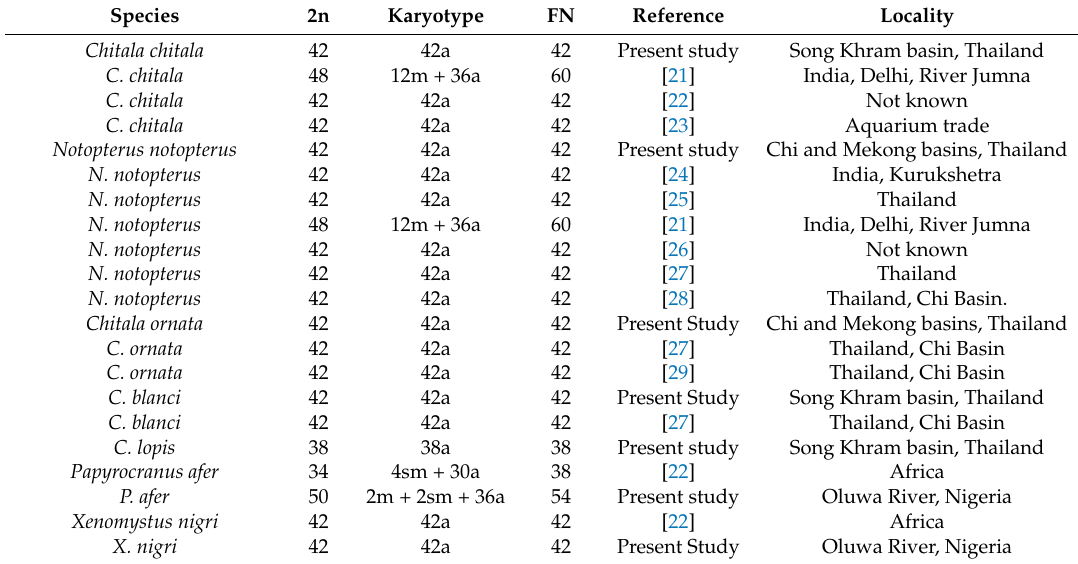
Table 1. Reviewofavailabledataon2n,